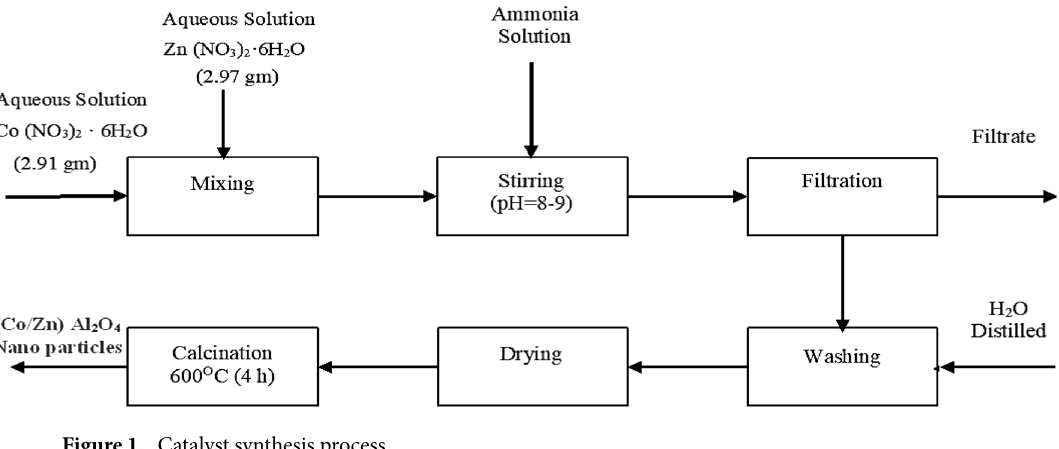
Figure 1. Catalyst synthesis